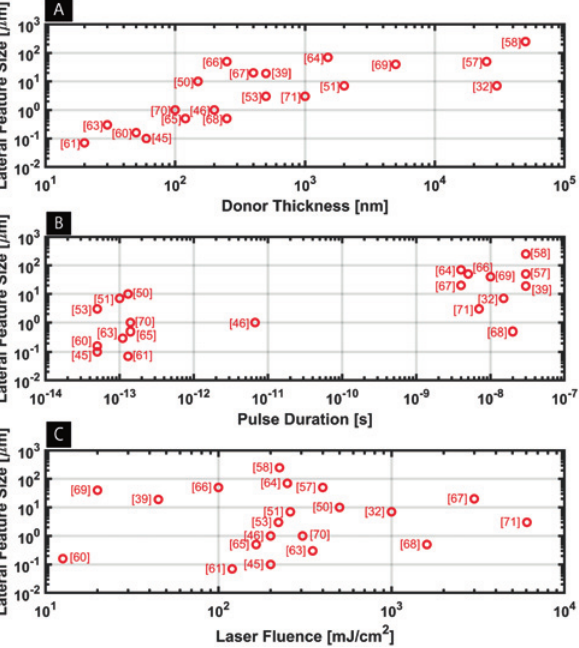
Figure4: DependenceoflateralfeaturesizeinLITasafunctionof(A) donor film thickness, (B) pulse duration, and (C) laser